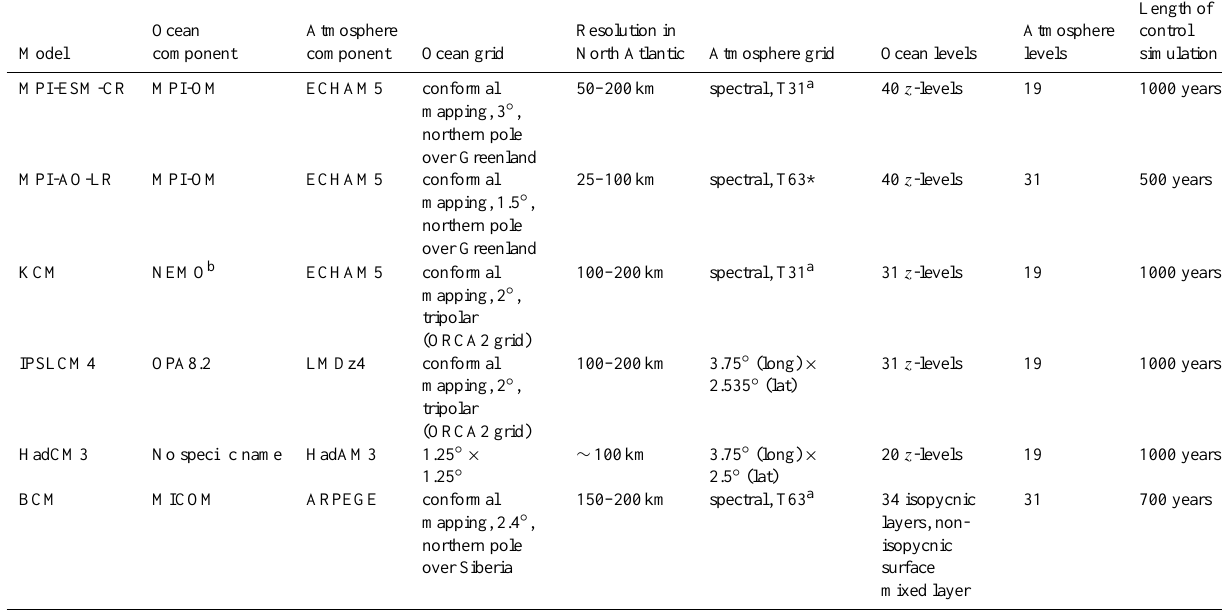
Table 1. Overview of the coupled climate models used in this